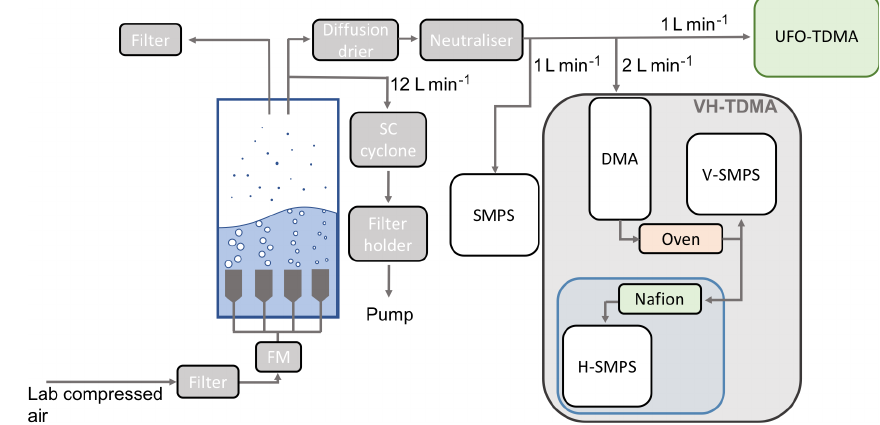
Figure 2. Experimental schematic of nascent SSA chamber experiments during SOAP voyage. The VH-TDMA (grey) contains an RH- controlled region (blue) used for water uptake